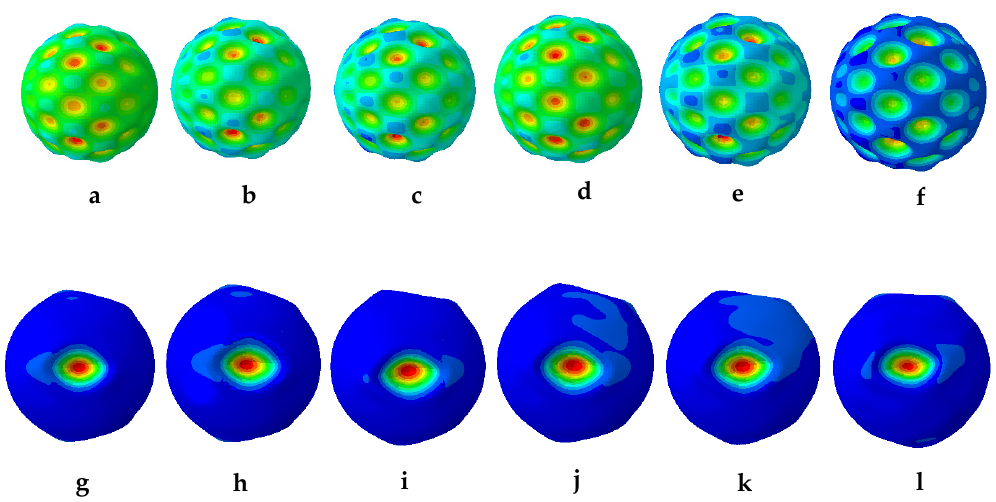
Figure 8. Critical buckling modes ( a – f ) and post-buckling modes ( g – l ) of the spherical composite pressure hull for 1 mm, 2 mm, 3 mm, 4 mm, 5 mm, and 10 mm size of imperfections in the case of worst buckling mode imperfection.